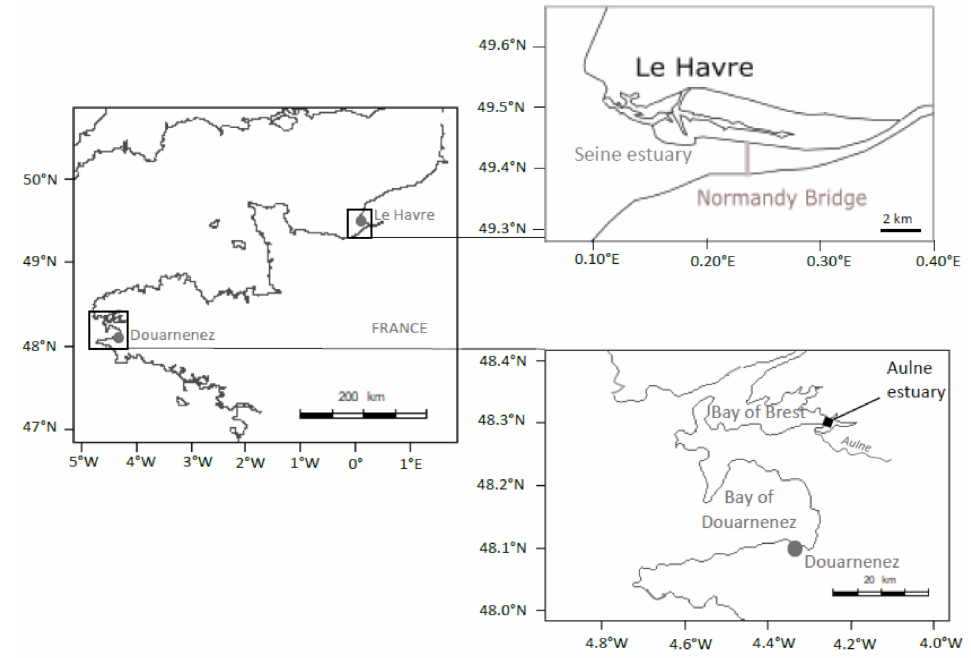
Figure 1. Location of sampling sites (Seine Estuary, Bay of